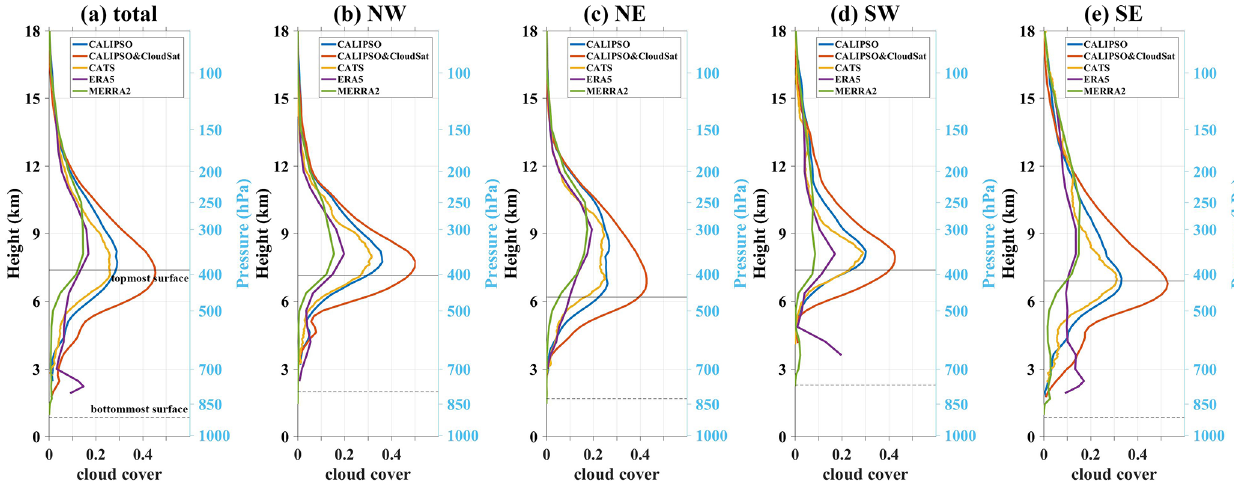
Figure 4. The cloud vertical distribution in different regions of the TP based on CALIPSO (blue lines), 2B-GEOPROF-LIDAR (CALIPSO&CloudSat, red lines), CATS (yellow lines), ERA5 (purple lines), and MERRA-2 (green lines) at the hour closest to the CloudSat and CALIPSO daytime overpass time: (a) the whole TP, (b) the northwestern TP, (c) the northeastern TP, (d) the southwestern TP, and (e) the southeastern TP. The regions are divided by latitude and longitude lines of 33 ◦ N and 89 ◦ E and the boundary of the TP (shown in Fig. 1). The height here represents the height above the mean sea level. The horizontal solid black lines represent the topmost surface altitude, and the dashed black lines represent the bottommost surface altitude obtained in the CATS digital elevation